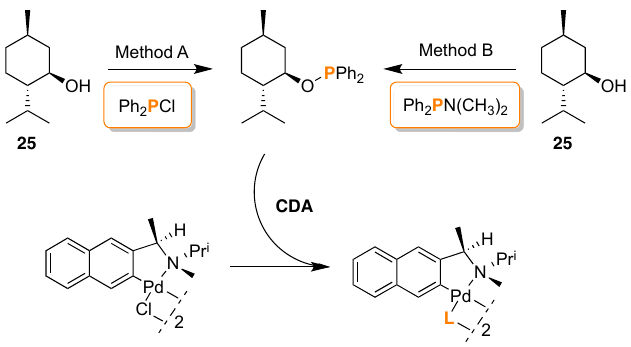
High accuracy and precision